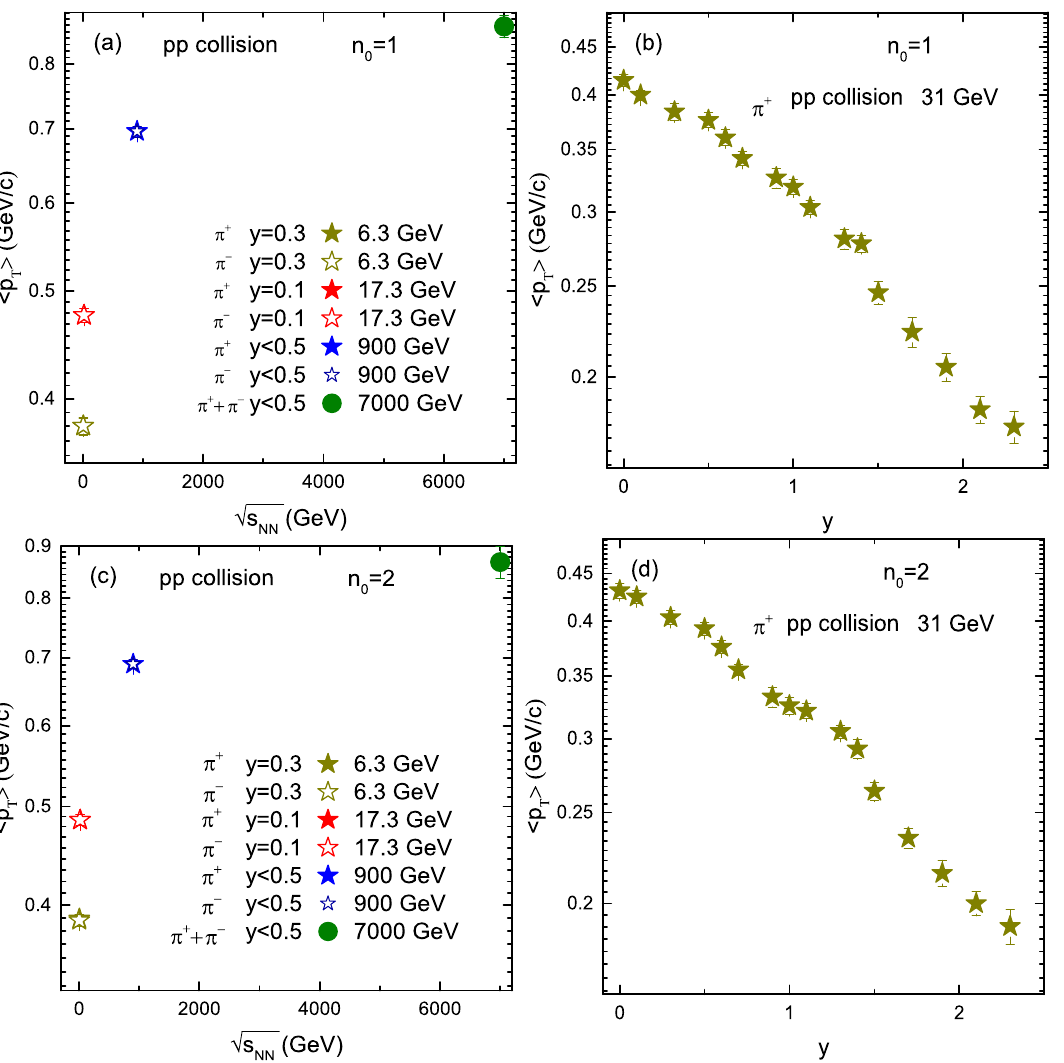
Figure 7. Dependence of the multiplicity parameter < p T > on collision energy as well as rapidity at 31 GeV. Panels ( a , c ) show the dependence of < p T > on collision energy by using the flow profile n 0 = 1 and 2, respectively, in the TBW model, while panels ( b , d ) show its dependence on rapidity at 31